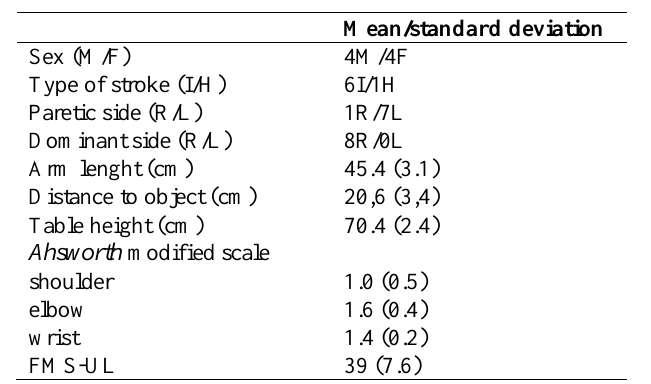
Table 1. Participants characteristics, anthropometric data, measures for kinematic evaluation and results of clinical evaluation.